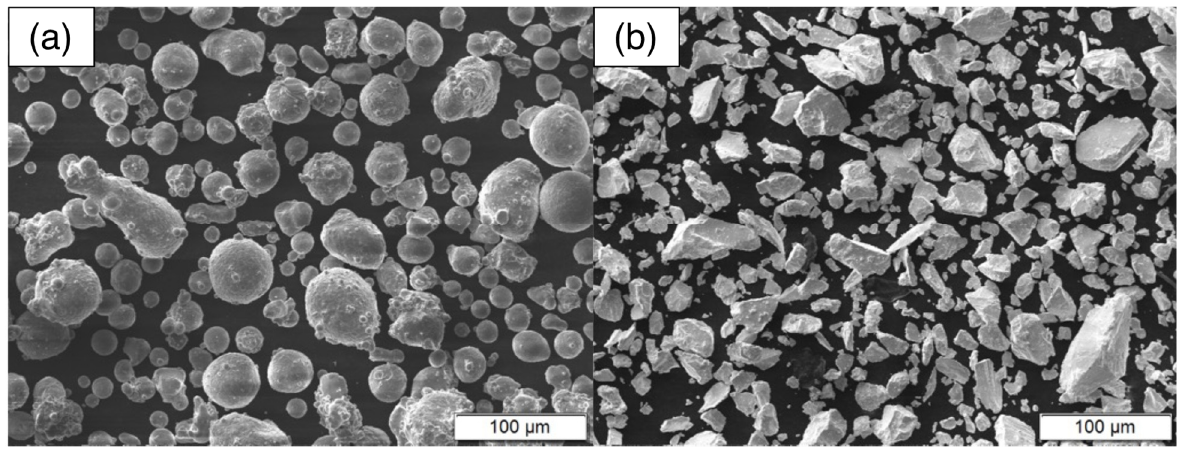
Figure 2. SEM micrographs of the ( a ) Al 5056 powder and ( b ) Ta powder.